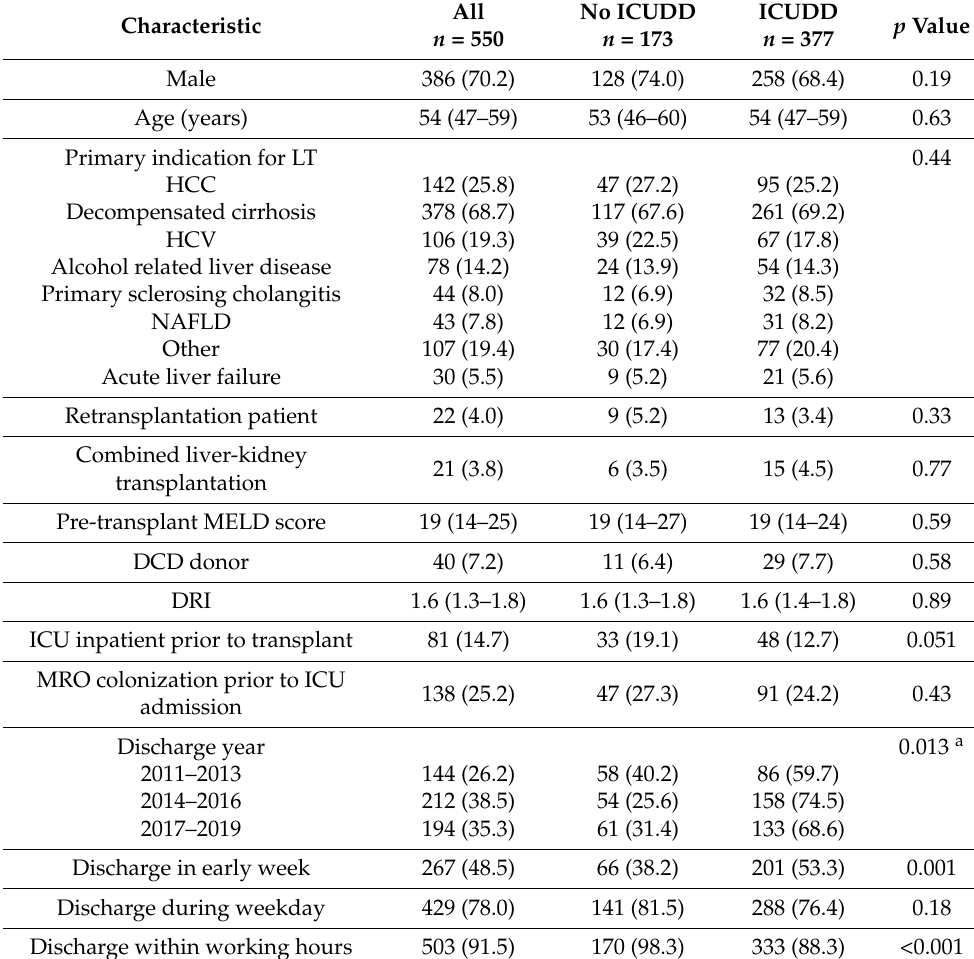
Table 1. Clinical characteristics of LT recipients with and without